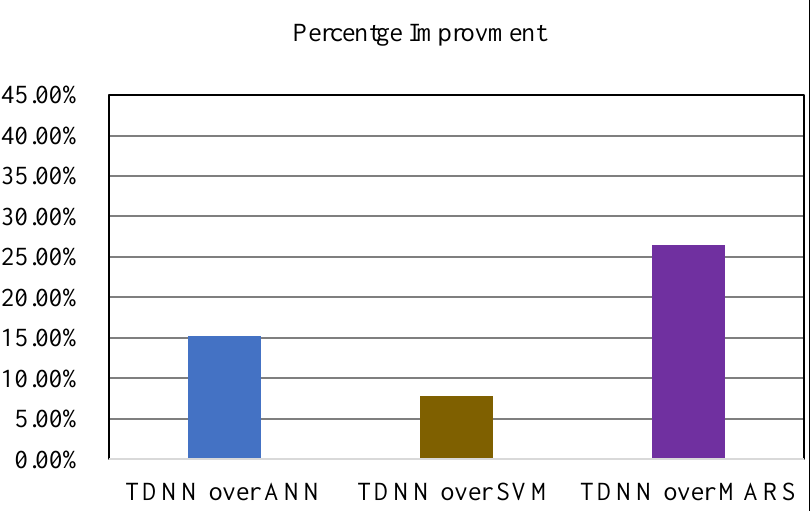
Figure 3. The AIRPI obtained by using the TDNN classifier over the ANN, SVM and MARS classifiers for an MNP 9 .